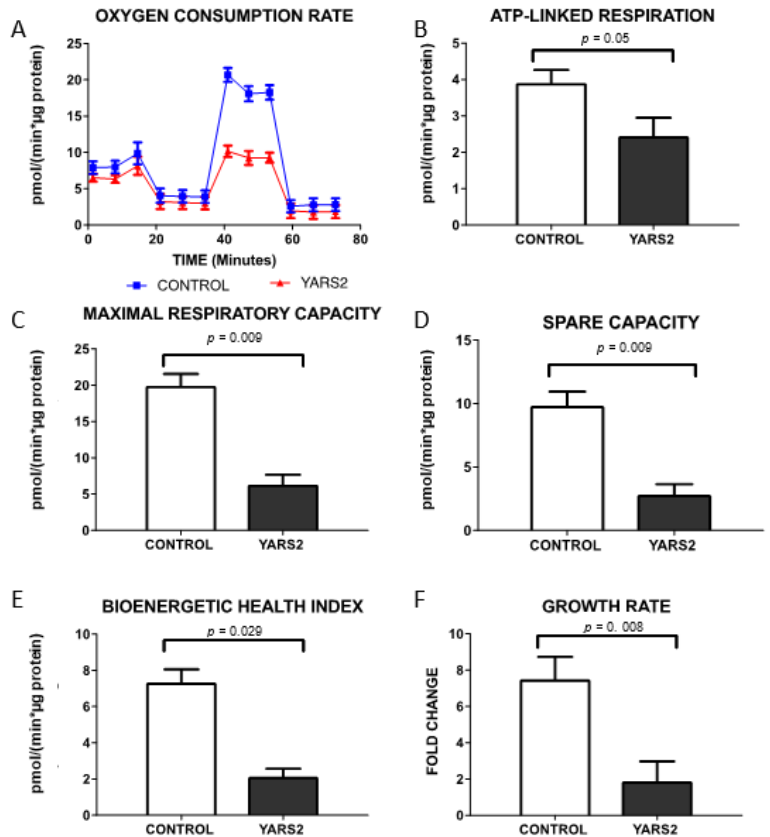
Figure 4. Mitochondrial functional characterization, overall cell health and growth rates. ( A ) Oxygen consumption rate was slightly decreased in fibroblast from patient P1. ( B ) The alteration is made more evident after MRC CV inhibition by oligomycin (ATP ‐ linked respiration). ( C ) Decrease in posterior mitochondrial uncoupling (maximal respiration capacity) and ( D ) spare capacity. ( E ) BHI is significantly reduced and ( F ) growth rate in galactose media was significantly affected in the patient P1 with YARS2 candidate